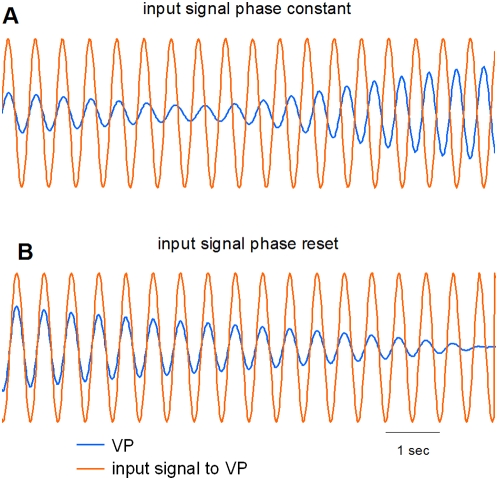
Response of the virtual partner (blue curve) to a sinusoidal input (orange curve).Sine input has the same frequency and fixed amplitude. The plots are time series of positions. (A) After starting out at in-phase, the coordination pattern switches to the virtual partner's preference at anti-phase. This switch is accompanied first by reduction then by an increase in the amplitude. (B) If the sinusoidal input is periodically reset so as to be in-phase with the virtual partner, the virtual partner amplitude decreases and does not recover. For the full VPI experiment, this has the effect of degrading the visual information required by the subject to coordinate effectively with the virtual partner.